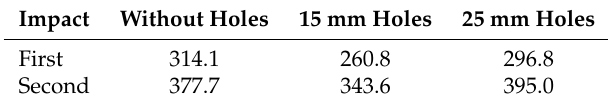
Figure 15. Comparison of the acceleration response between the solid and holed liner versions made of AC216. Table 11. Peak accelerations measured for each AC216 liner